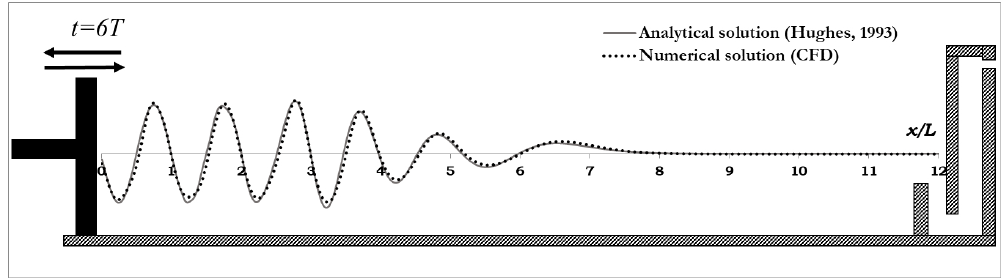
Figure 5. Free surface displacement η , as a function of relative distance x / L , where L represents the wavelength. Comparison between analytical solution (continuous line) for transient waves in a flume (Huges, 1993) and the numerical solution (dotted line) carried out by CFD simulation ( H = 2.5 m, T = 8